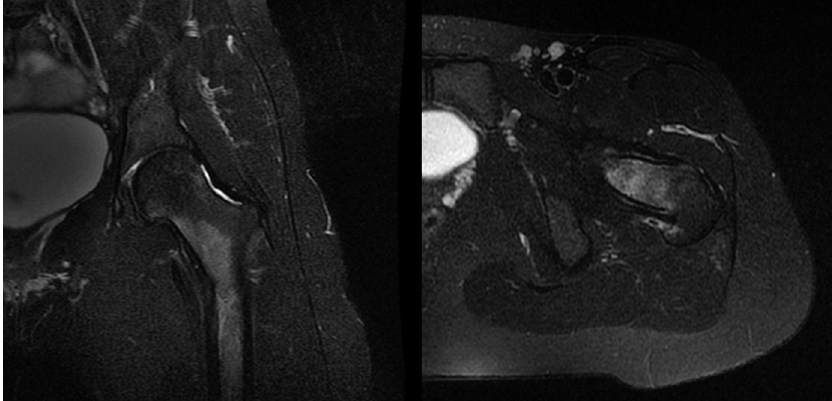
Figure 3. MRI of the left hip, STIR sequence, showing hyperintense signal, characteristic of a compression type femoral neck stress fracture.